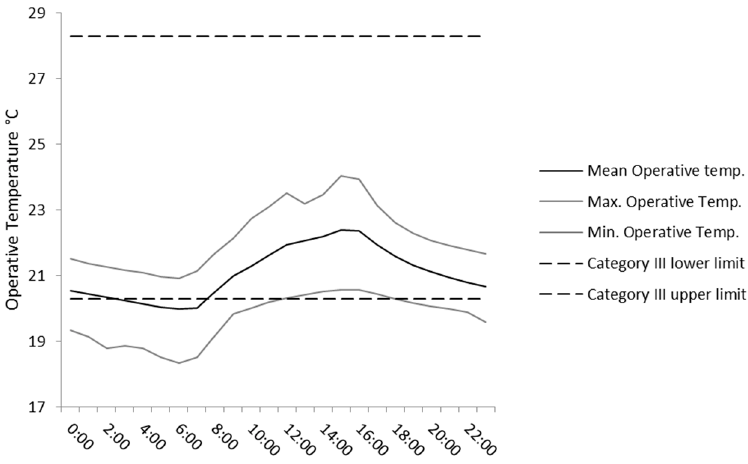
Figure 13. Plot of operative temperature against time of day.